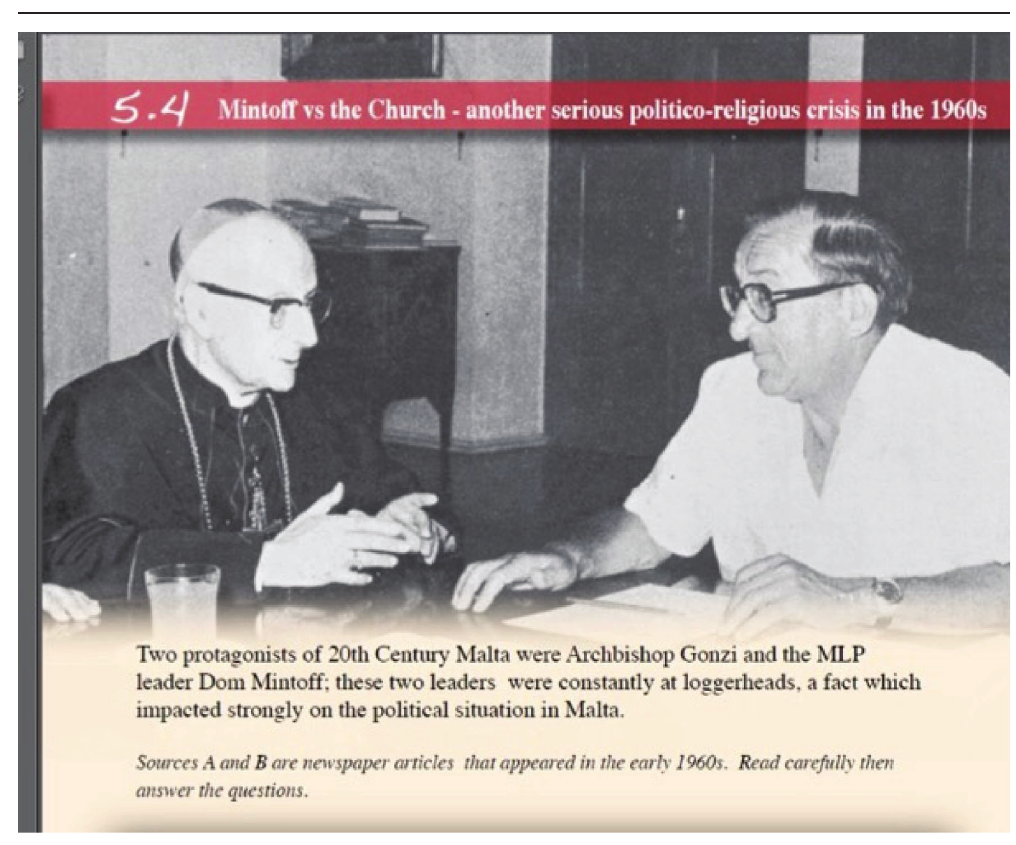
Figure 1: Textbook illustration of the two leaders of the dispute Source : Vella (2008: 75–6)